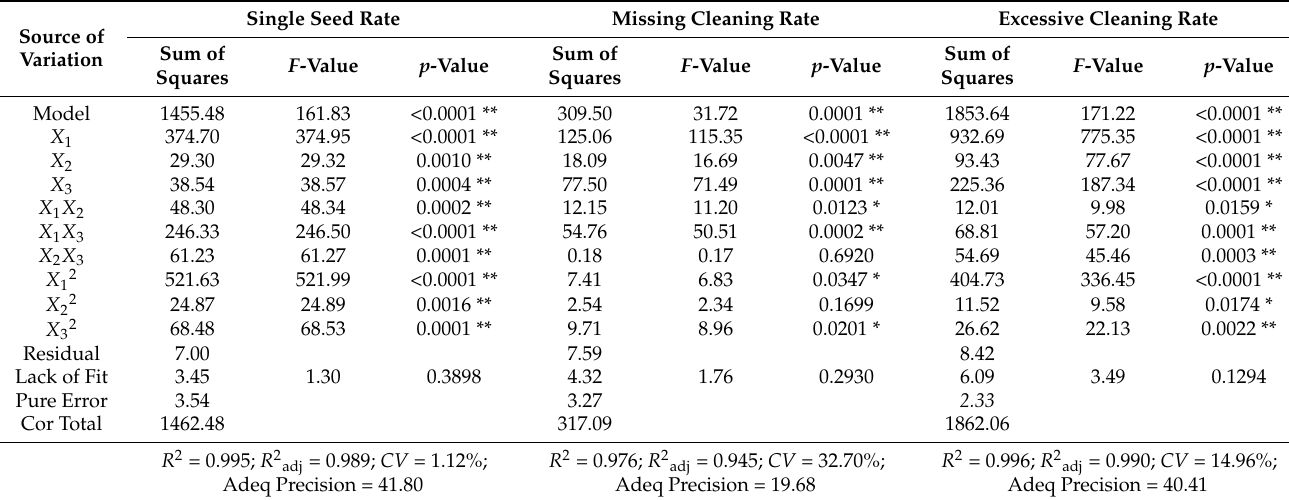
Table 4. Variance analysis of Box–Behnken test